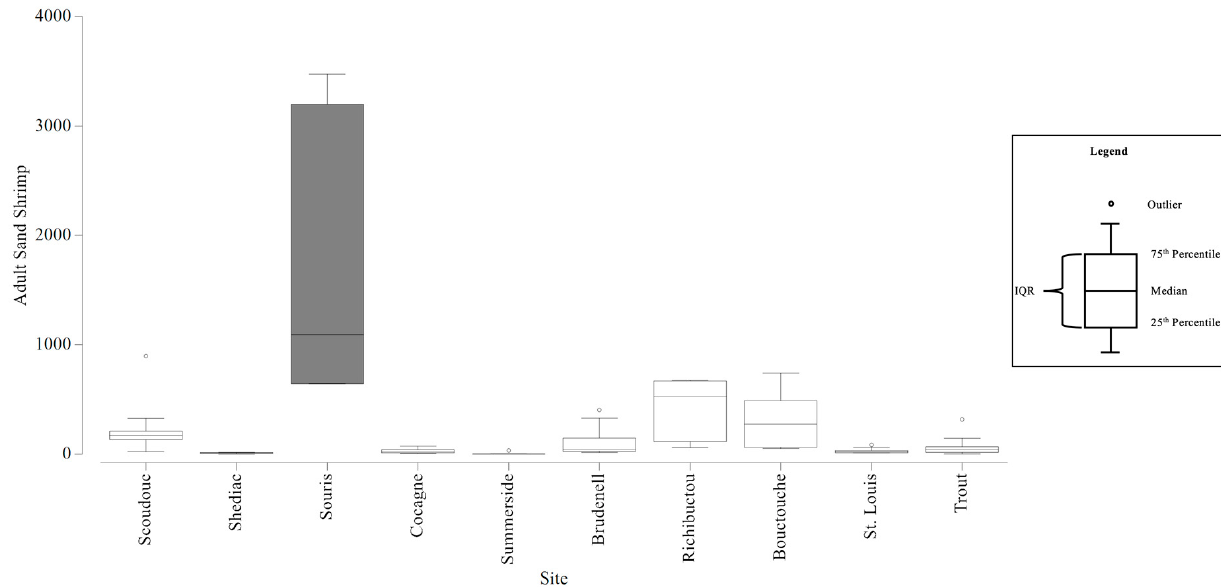
Figure 7. Boxplots generated using the adult Sand Shrimp counts collected from the Community Aquatic Monitoring Program (CAMP) stations at each estuary. The box shaded dark grey identifies the adult Sand Shrimp abundances that are significantly different from the abundances at the other estuaries, and the difference is large enough to be detected, with confidence, in consideration of the precision of the CAMP sampling design. Circles above the boxplots (i.e., outliers) are outside 1.5 times the interquartile range (IQR).